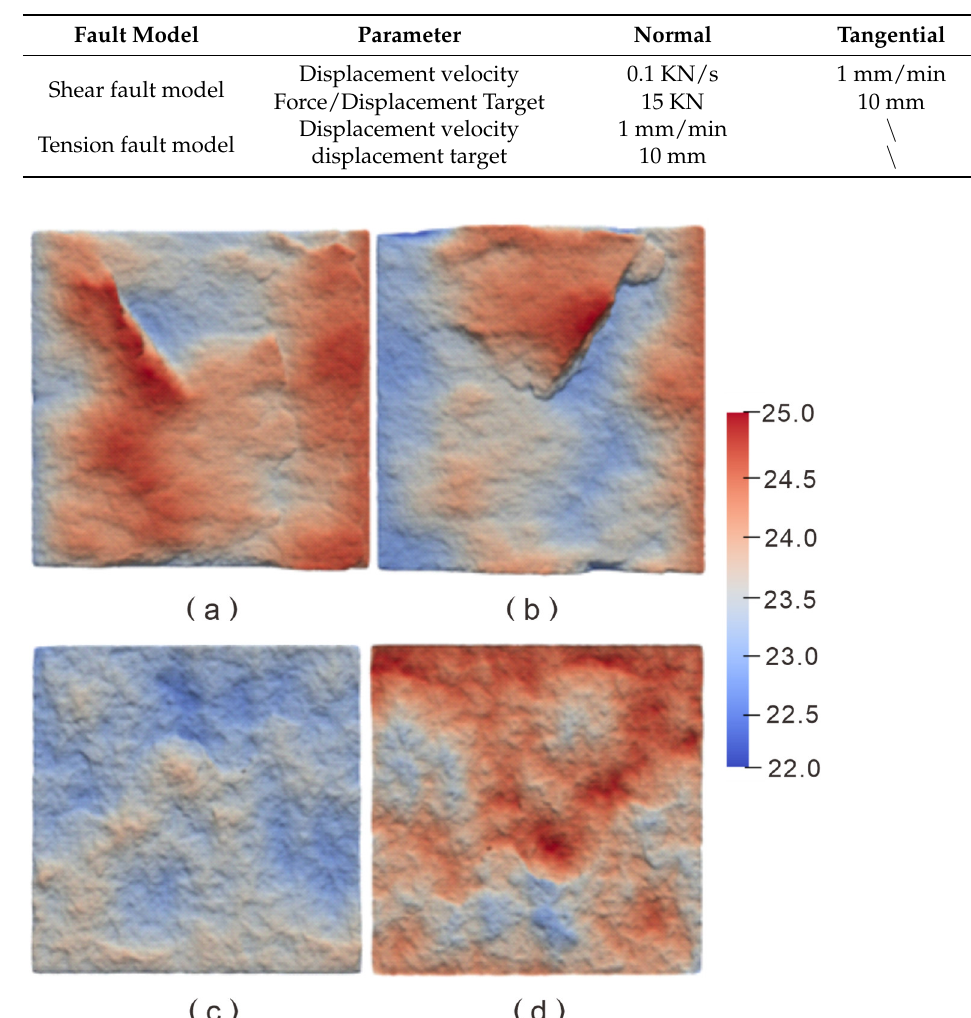
Table 3. Experimental parameters of initial shear fault plane and tension fault plane.